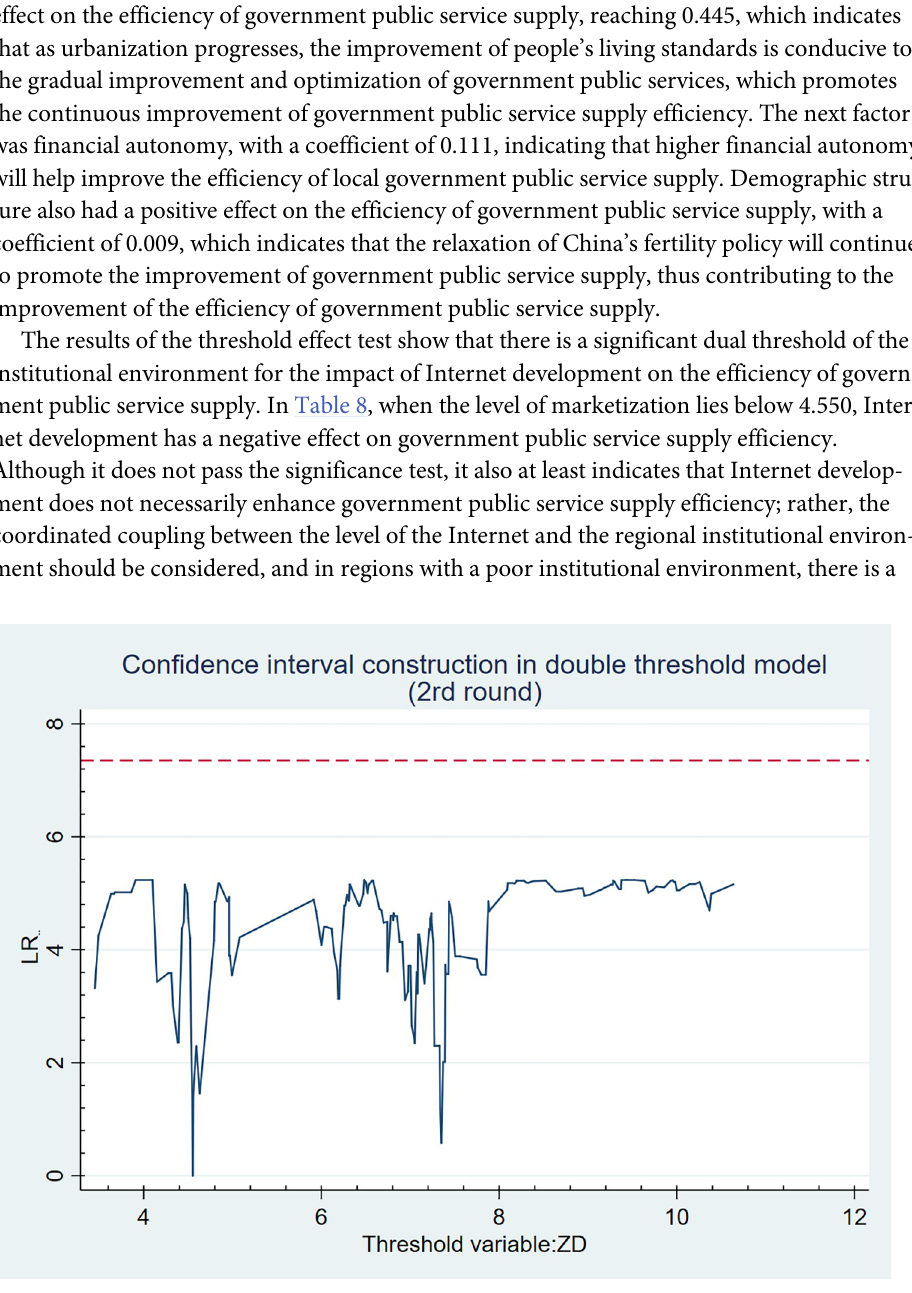
Fig 1. The likelihood ratio function diagram of the first threshold